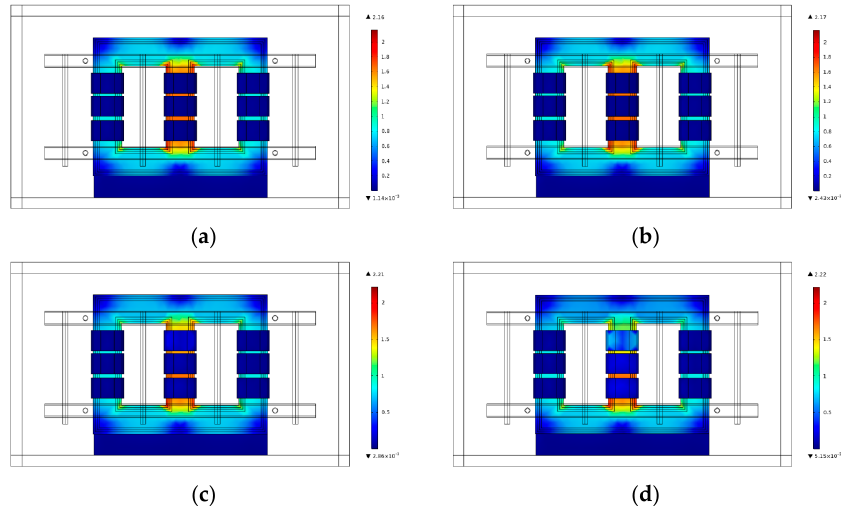
Figure 6. The distribution of transformer magnetic field under interturn fault, which should be listed as: ( a ) The distribution of magnetic field of R (cid:2915)(cid:2927) = 1 Ω ; ( b ) The distribution of magnetic field of as: ( a ) The distribution of magnetic field of R eq = 1 Ω ; ( b ) The distribution of magnetic field of R (cid:2915)(cid:2927) = 0.5 Ω ; ( c ) The distribution of magnetic field of R (cid:2915)(cid:2927) = 0.1 Ω ; ( d ) The distribution of magnetic R eq = 0.5 Ω ; ( c ) The distribution of magnetic field of R eq = 0.1 Ω ; ( d ) The distribution of magnetic field of R (cid:2915)(cid:2927) = 0.01 Ω . field of R eq = 0.01 Ω